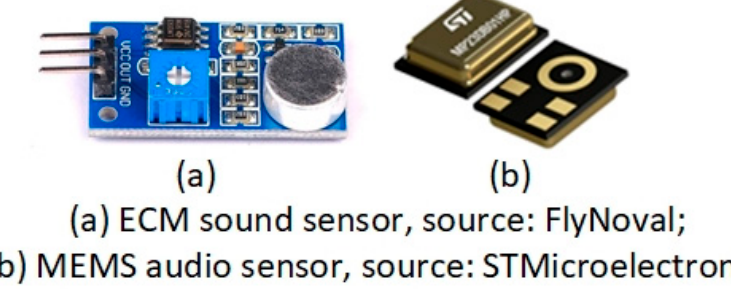
Figure 8. Examples of sound sensor.